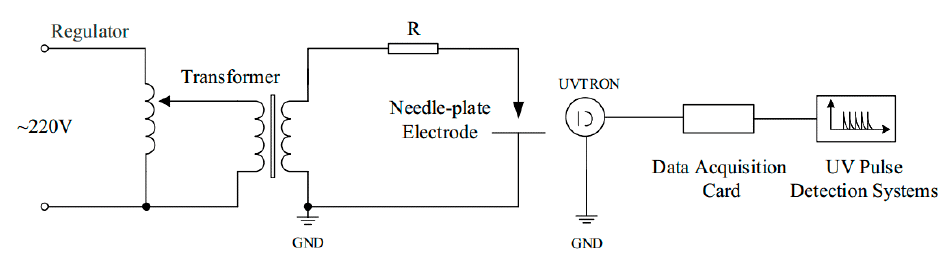
Figure 11. Needle-plate corona discharge test circuit.